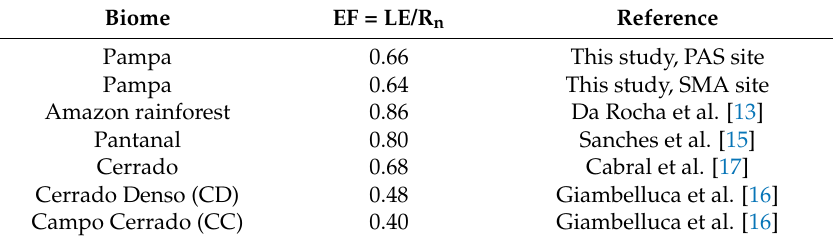
Table 2. Annual mean of evaporative fraction (EF) of various Brazilian biomes.